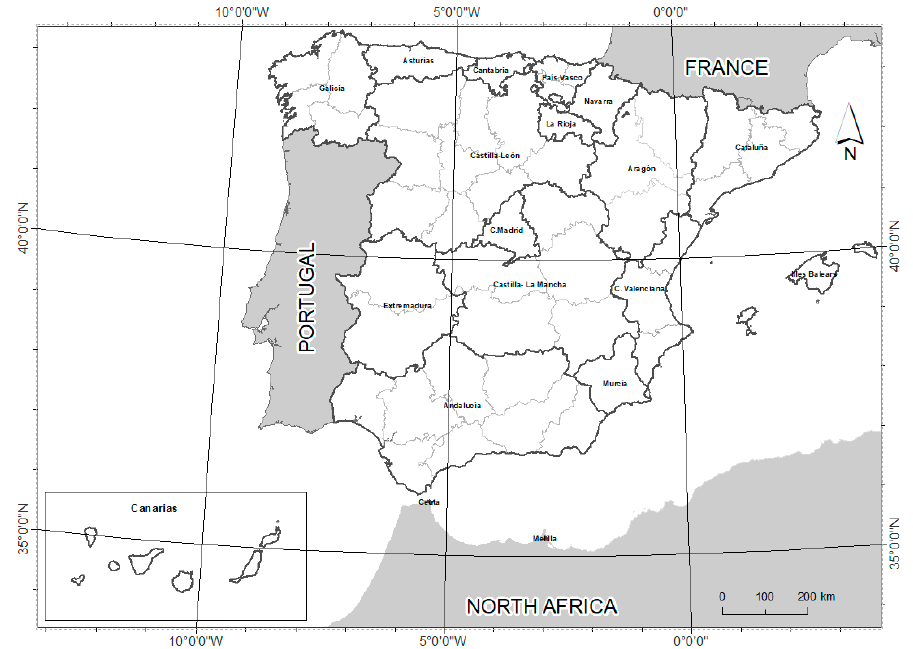
Figure A1. Map of the current regions of Spain.